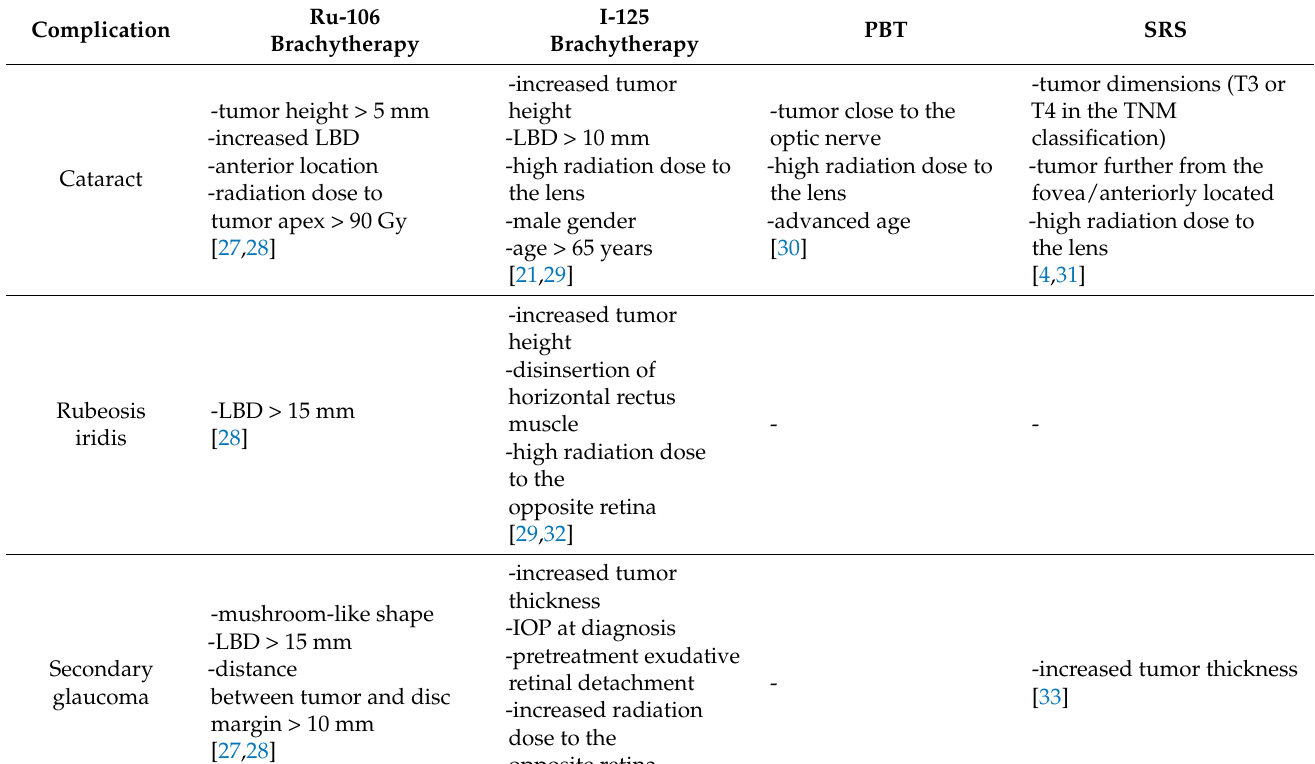
Table 2. Risk factors associated with the development and time to the development of different